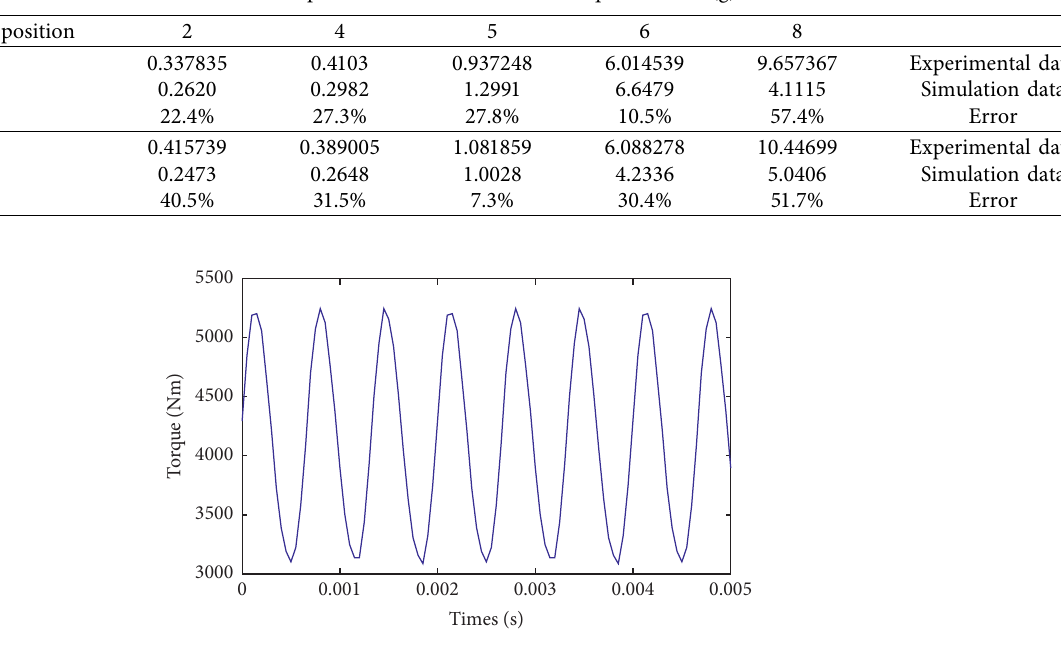
Figure 18: Simulation acceleration values at measuring point 3. (a) Simulation results for time domain acceleration at measuring point 3. (b) Simulation results for frequency domain acceleration at measuring point 3. Table 4: Comparison of acceleration mean square values (g).